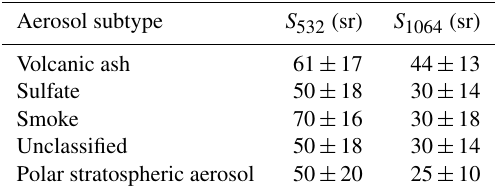
Table 2. Lidar ratios for stratospheric aerosol subtypes in